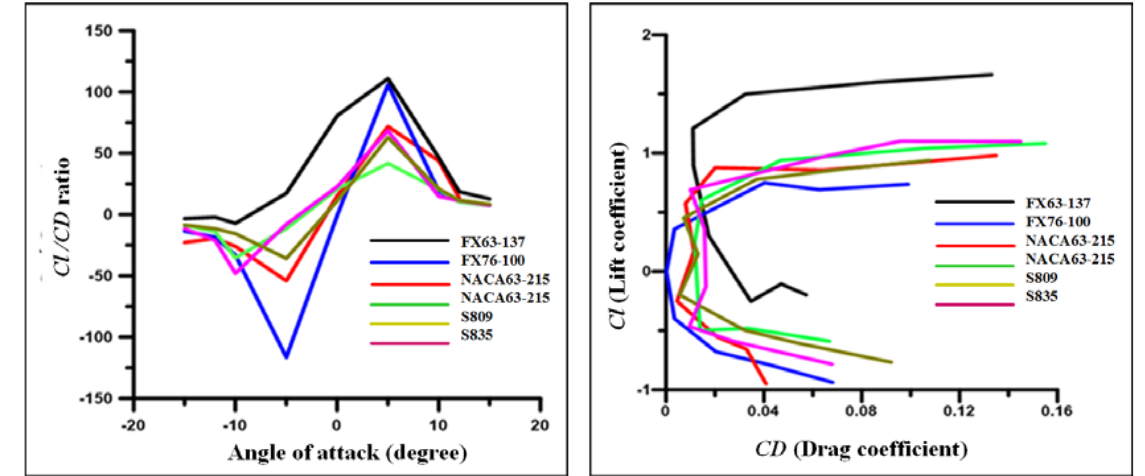
Figure 8. The C l / C d coefficient as a function of α ◦ and the lift coefficient as a function of the drag coefficient.